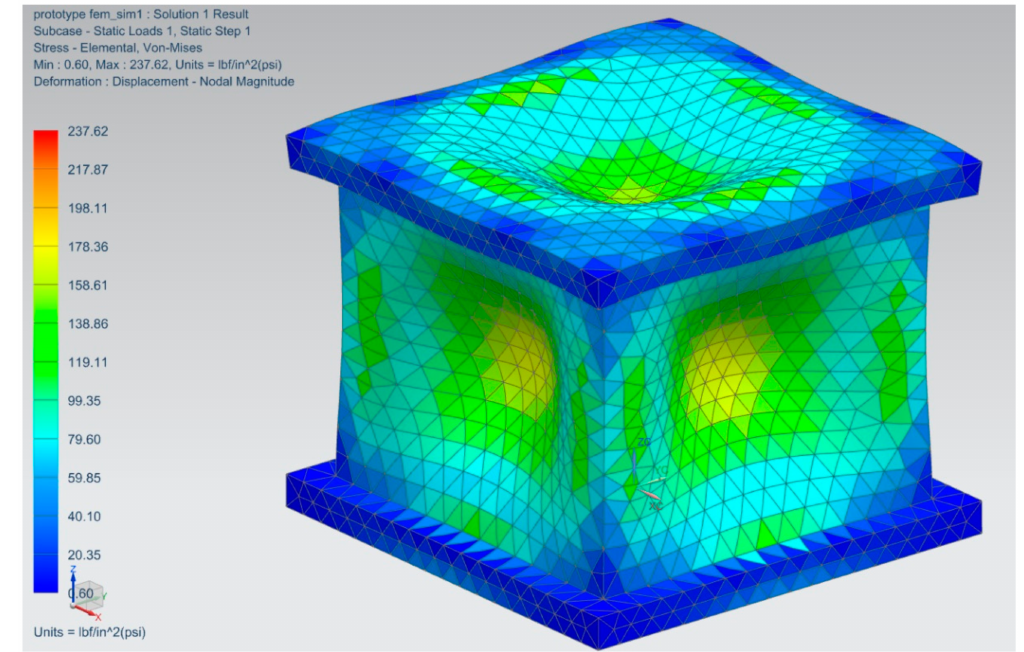
Figure 4. The chamber base stress